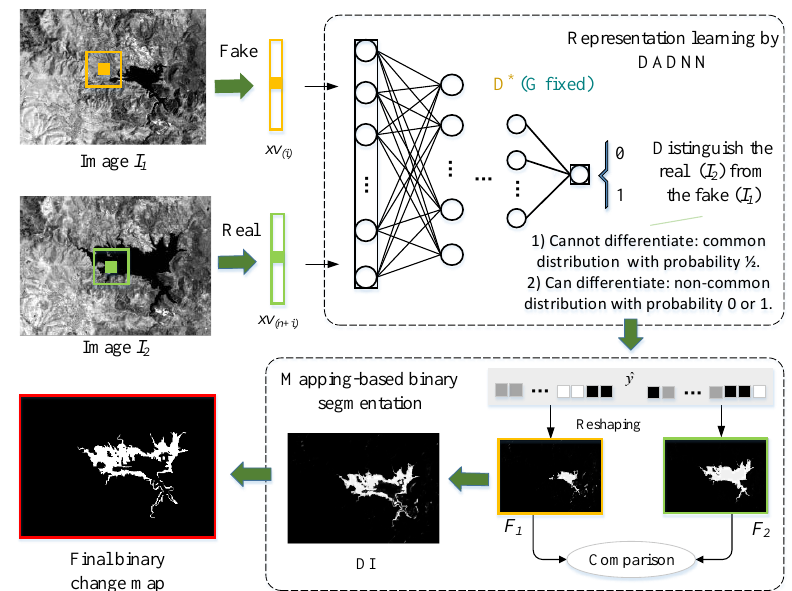
Figure 2. The workflow of the proposed method. First, the proposed network is trained to learn the mapping relationship based on the intensity distribution of the same type in two images. Second, two input images are respectively fed into the trained networks and generate two corresponding feature maps. Finally, a binary change map is obtained by clustering the DI that is generated by directly comparing the two feature